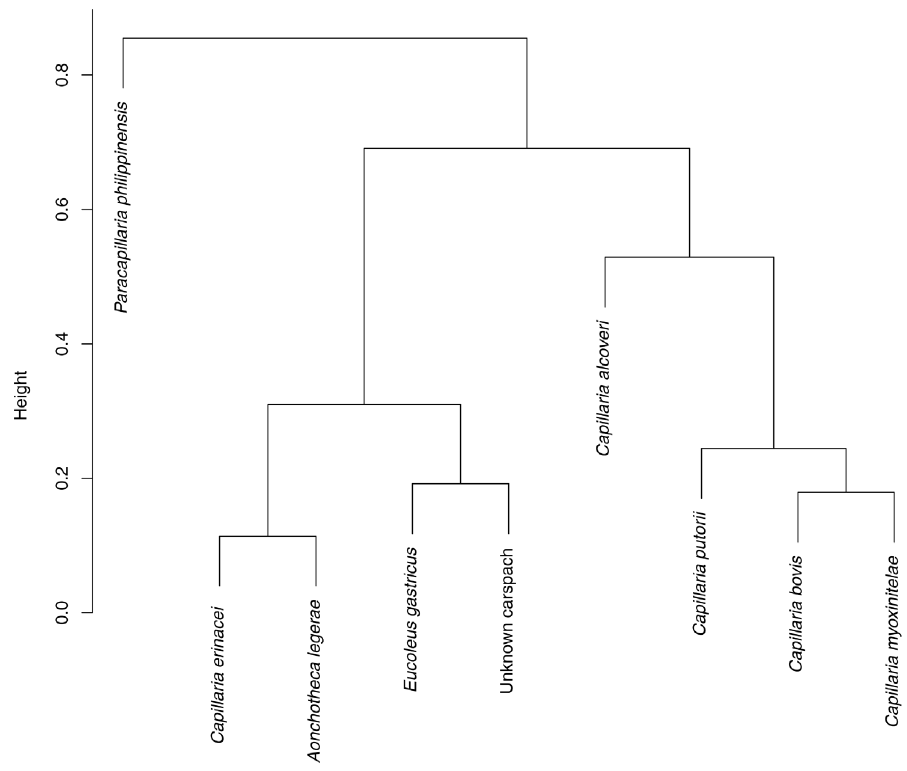
Figure 4. Hierarchical clustering established for capillariid reticulated eggs by using the Gower distance and the Ward minimum variance.